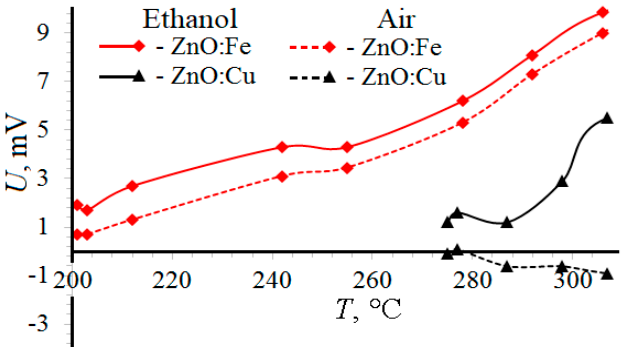
Figure 2. Temperature dependence of the electromotive force in ZnO / ZnO–Me structures with the upper layer formed by three immersions in the ethanol atmosphere of 1000 ppm.